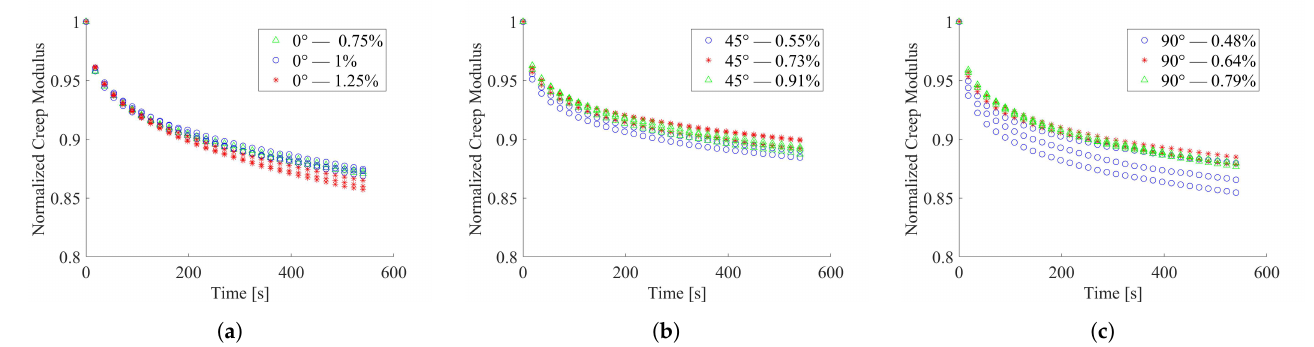
Figure 5. Normalized creep modulus over time at room temperature; ( a ) 0° infill orientation; ( b ) 45° in- fill orientation; ( c ) 90° infill orientation.